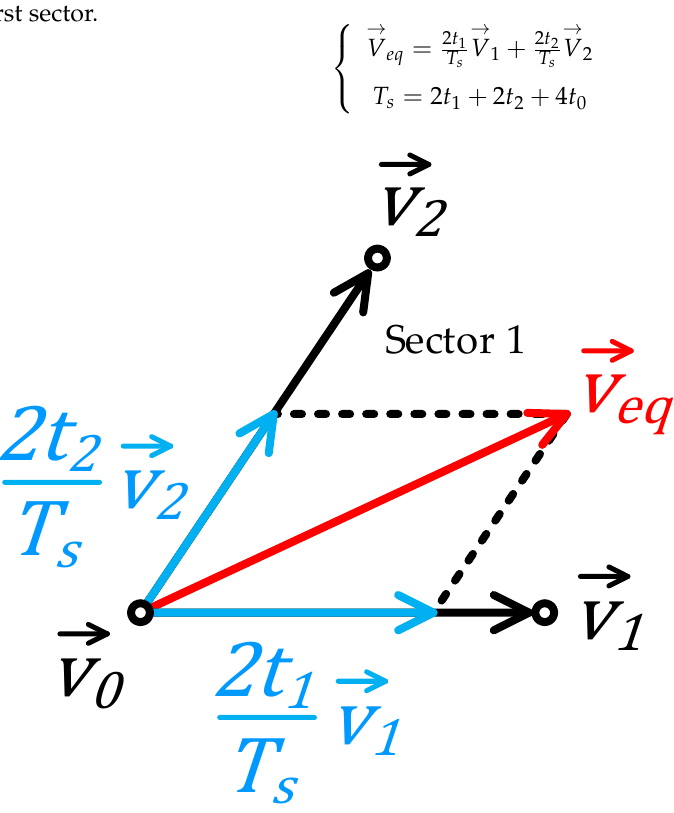
Figure 3. SVM Sector One Equivalent Voltage Synthesis.